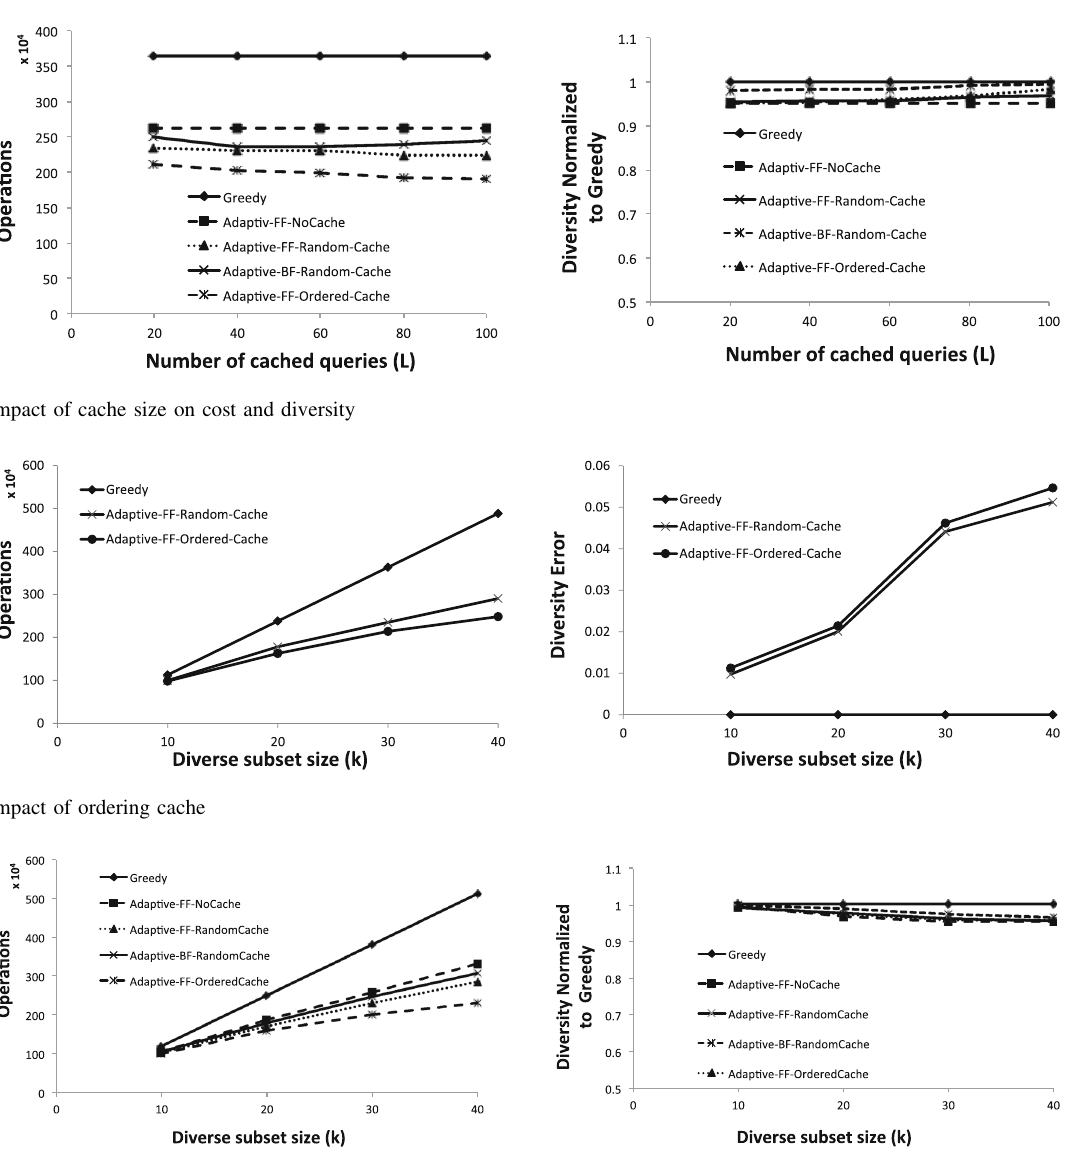
Fig. 15 Impact of varying k on cost and diversity (SDSS data